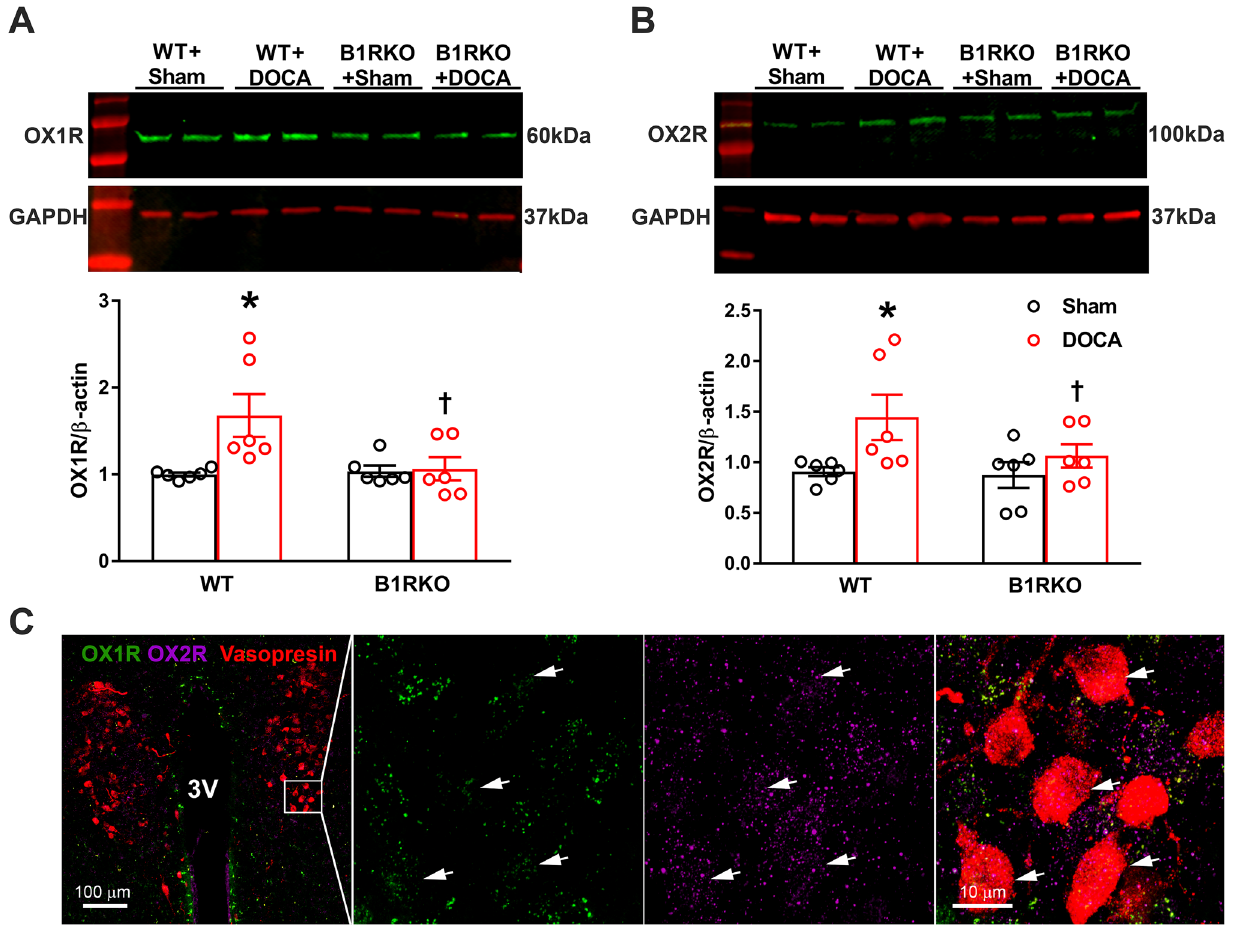
Figure 3. Orexin protein expression of orexin receptors within PVN. DOCA-salt treatment significantly increased ( A ) OX1R and ( B ) OX2R protein expression in the brain hypothalamic PVN of WT mice, which was prevented in B1RKO mice with DOCA-salt hypertension. Statistical significance: Two-way ANOVA followed by Tukey’s multiple comparisons test. * p < 0.05 versus WT + Sham; † p < 0.05 versus WT + DOCA; n = 6/group. ( C ) Triple immunofluorescence staining of OXR1 (green) and OXR2 (magenta) along with neuronal anatomical marker vasopressin (red) reveals OX1R and OX2R staining co-localized with PVN neurons as pointed by